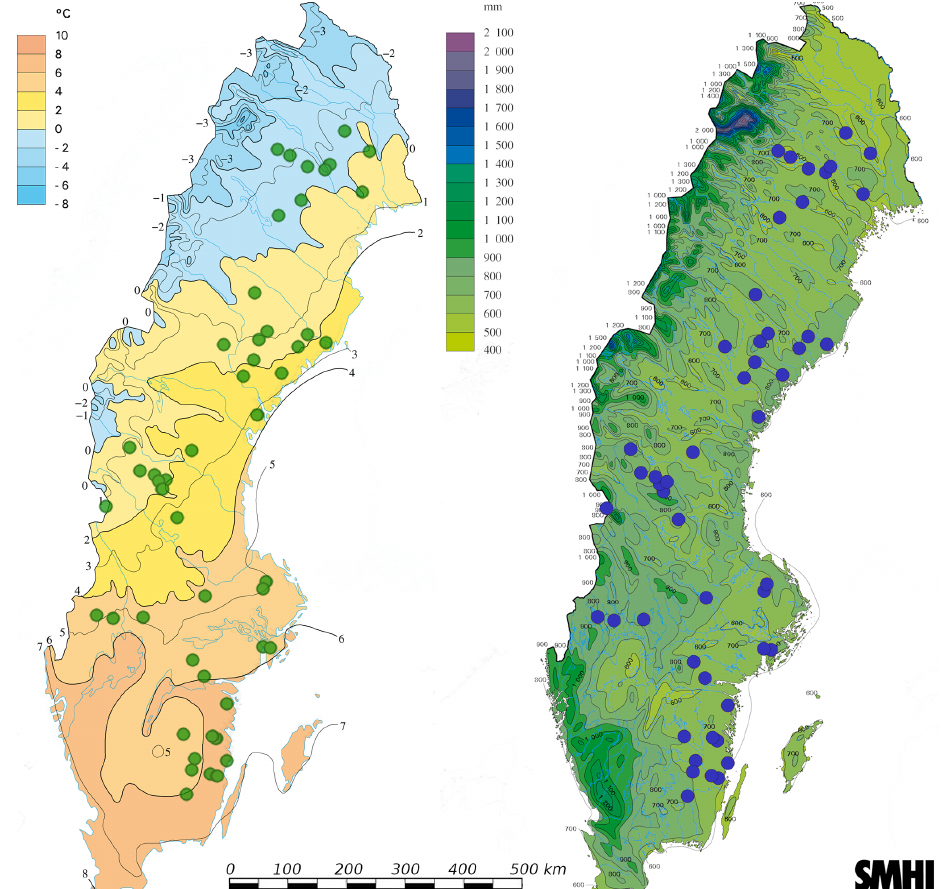
Figure 1. Using climate data averaged over the period 1961–2017 provided by the Swedish Meteorological and Hydrological Institute (SMHI) for plot selection, mean annual temperature (MAT; left image) had a range of 0.43–7.77 ◦ C and mean annual precipitation (MAP; right image) of 539–772mm over an approximately 57–67 ◦ latitudinal change. The 50 plot pairs were added as points to a figure provided by SMHI of MAT and MAP gradients over the last normal period